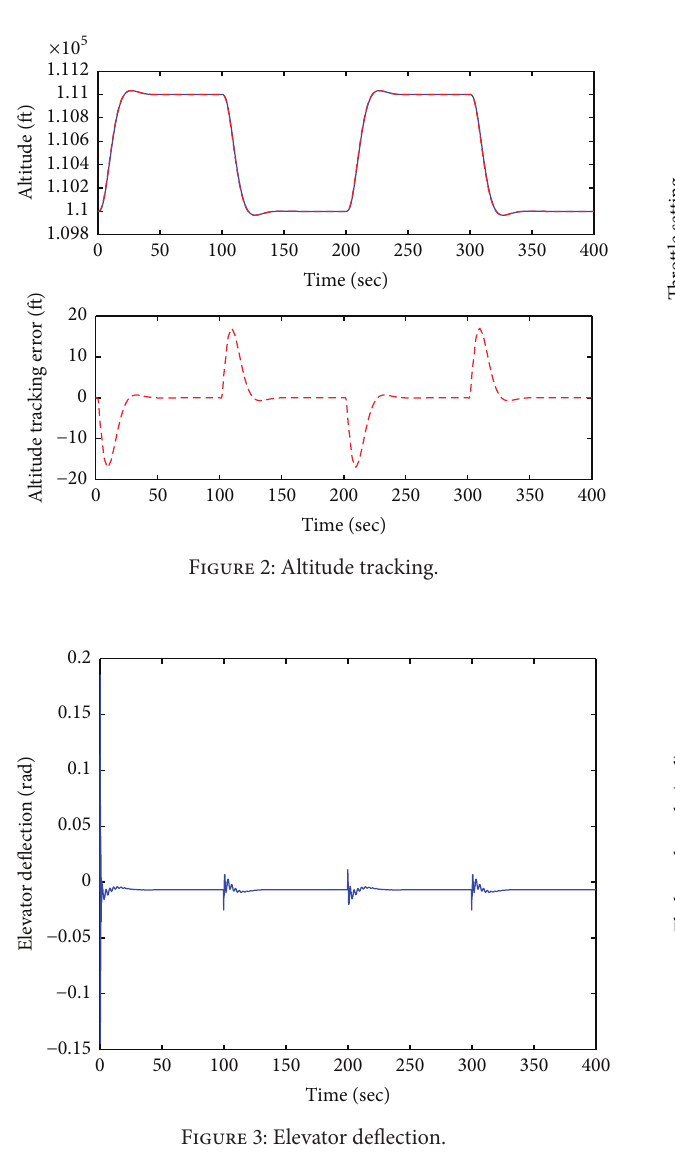
Figure 5: Flight path